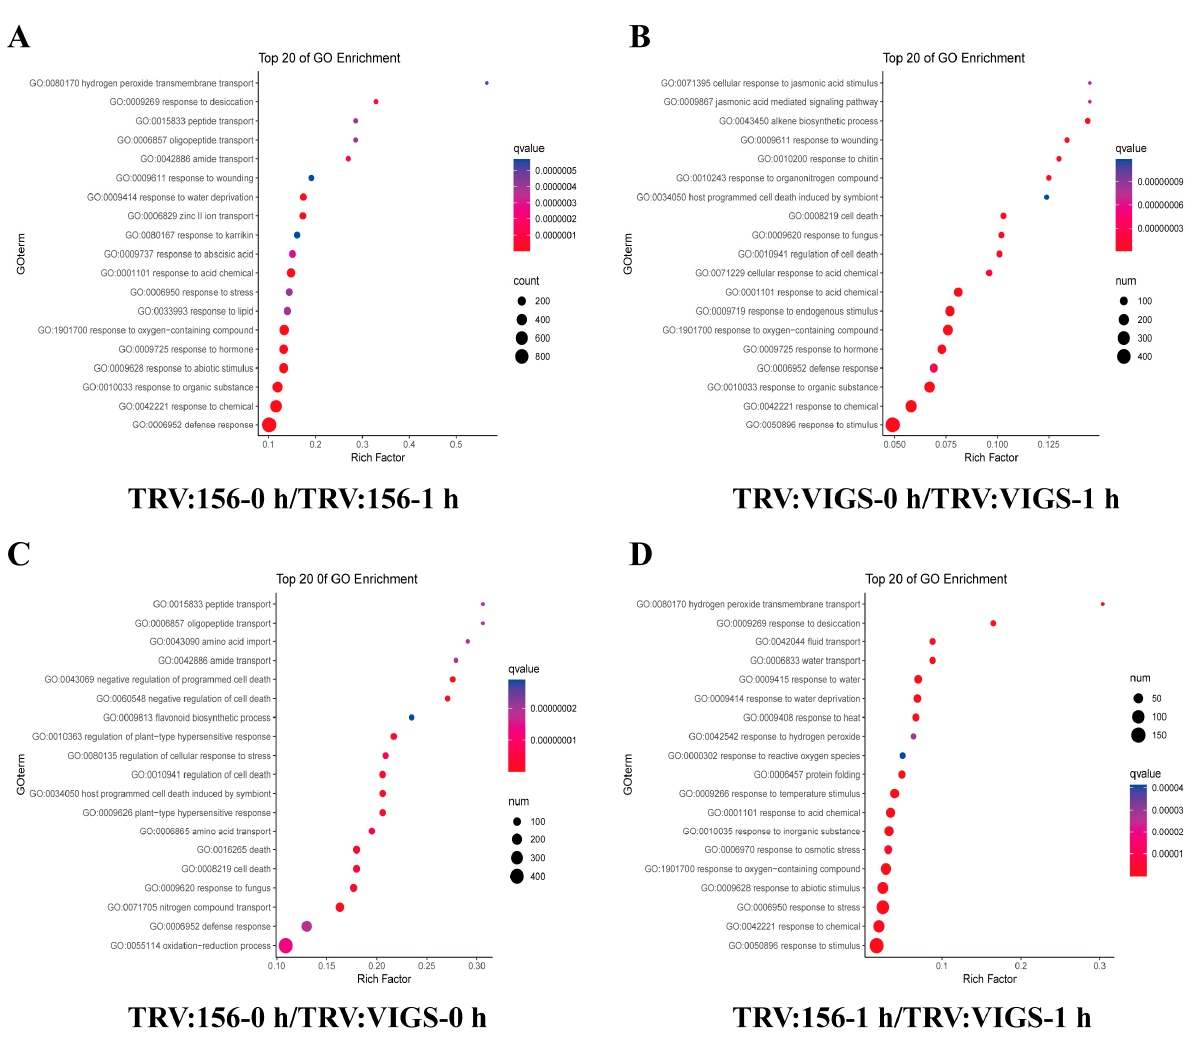
Figure 7. Gene ontology (GO) enrichment analysis. ( A ) GO terms of TRV:156-0 h/TRV:156-1 h ( B ) GO terms of TRV:VIGS-0 h/TRV:VIGS-1 h ( C ) GO terms of TRV:156-0 h/TRV:VIGS-0 h ( D ) GO terms of TRV:156-1 h/TRV:VIGS-1 h. Each circle in the figure represents a GO biological process, and the number of genes enriched in a pathway corresponds to the size of the circle. The degree of significance of the enrichment of DEGs in a pathway is represented by qvalue. The abscissa indicates the ratio of the number of DEGs annotated to a particular GO term to the number of the DEGs annotated to all GO terms.